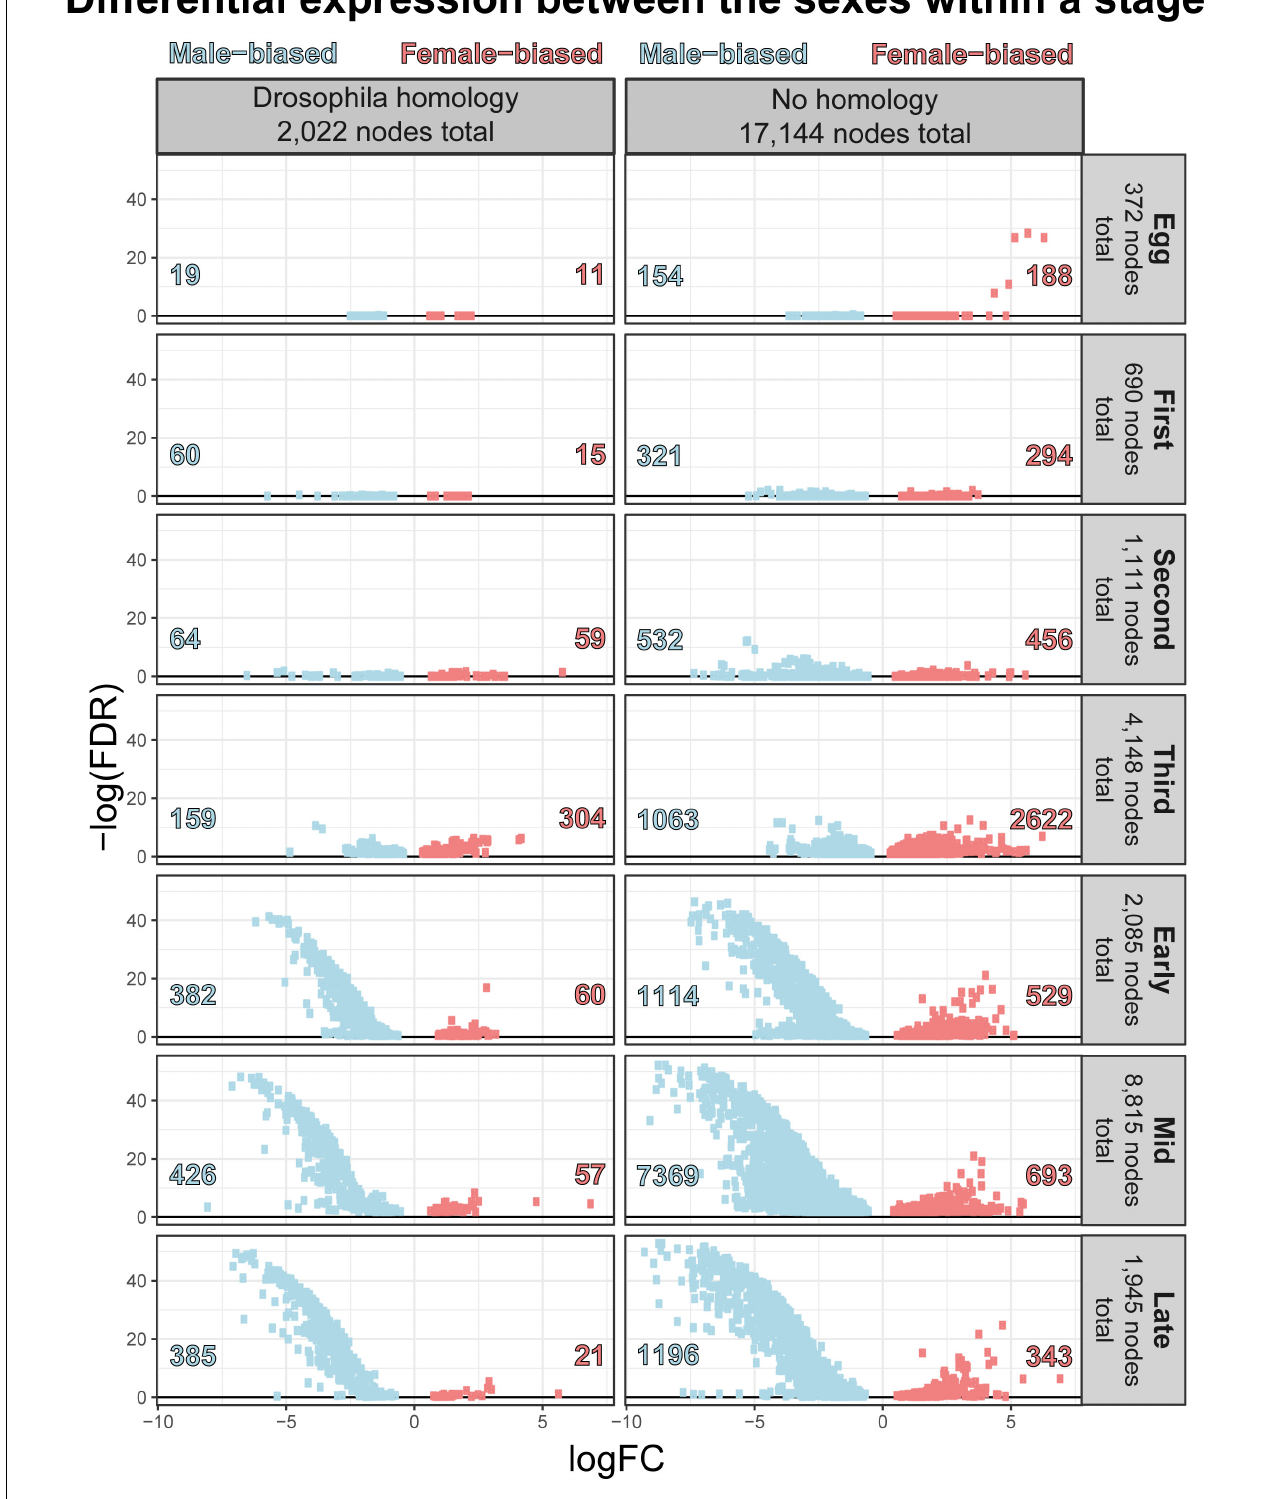
FIGURE 9 | Volcano plot of sexual dimorphism throughout immature development highlights the increasing number of nodes and strength of masculinization of Chrysomya rufifacies’ transcriptome as development progresses.